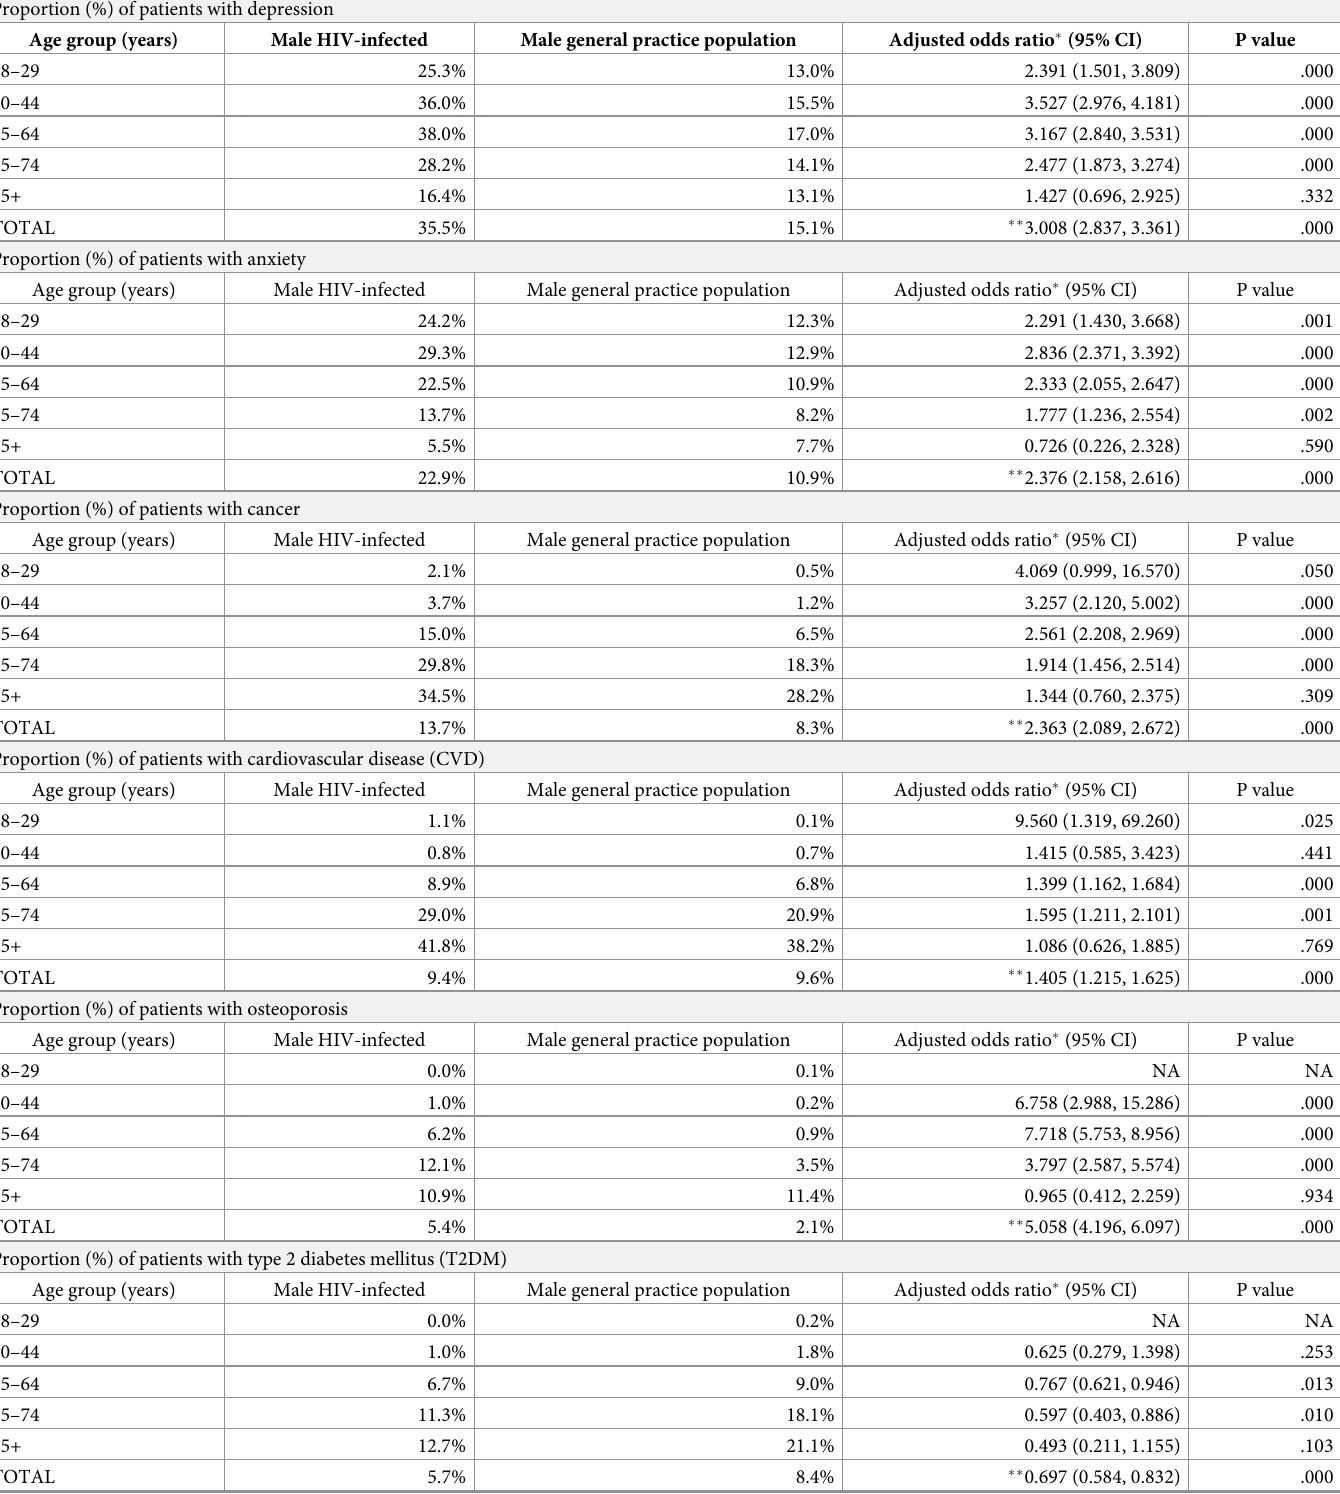
Table 2. Proportion and adjusted odds ratio of selected NICMs in male patients by HIV status and age group. Proportion (%) of patients with